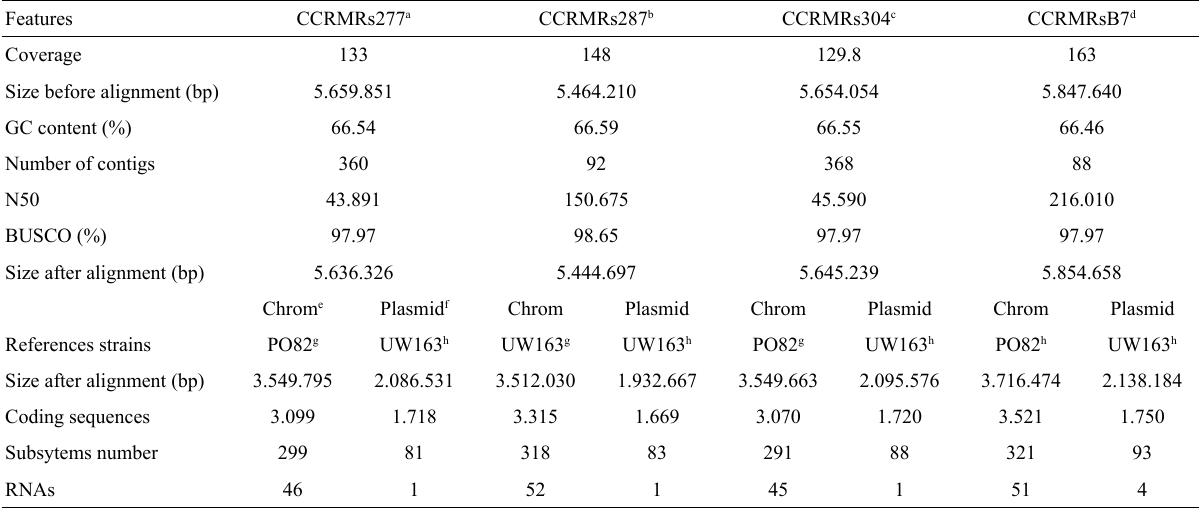
Table 1 - Characteristics of the genome sequences of four different R. solanacearum strains of the Moko ecotype from Brazil.